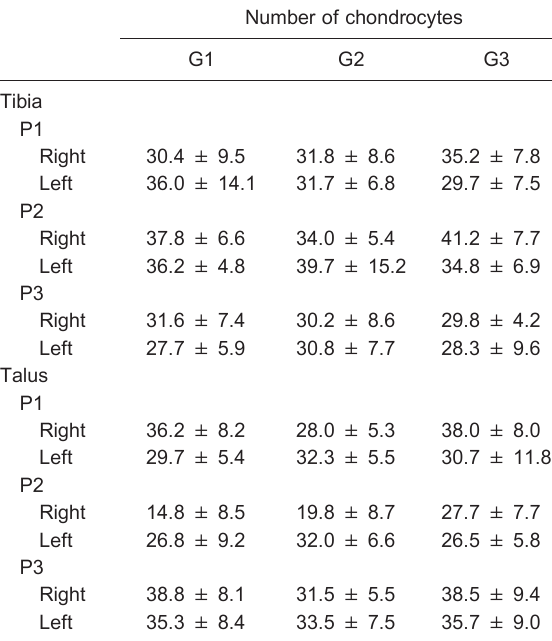
Table 2. Articular cartilage thickness ( m m) of the tibia and the